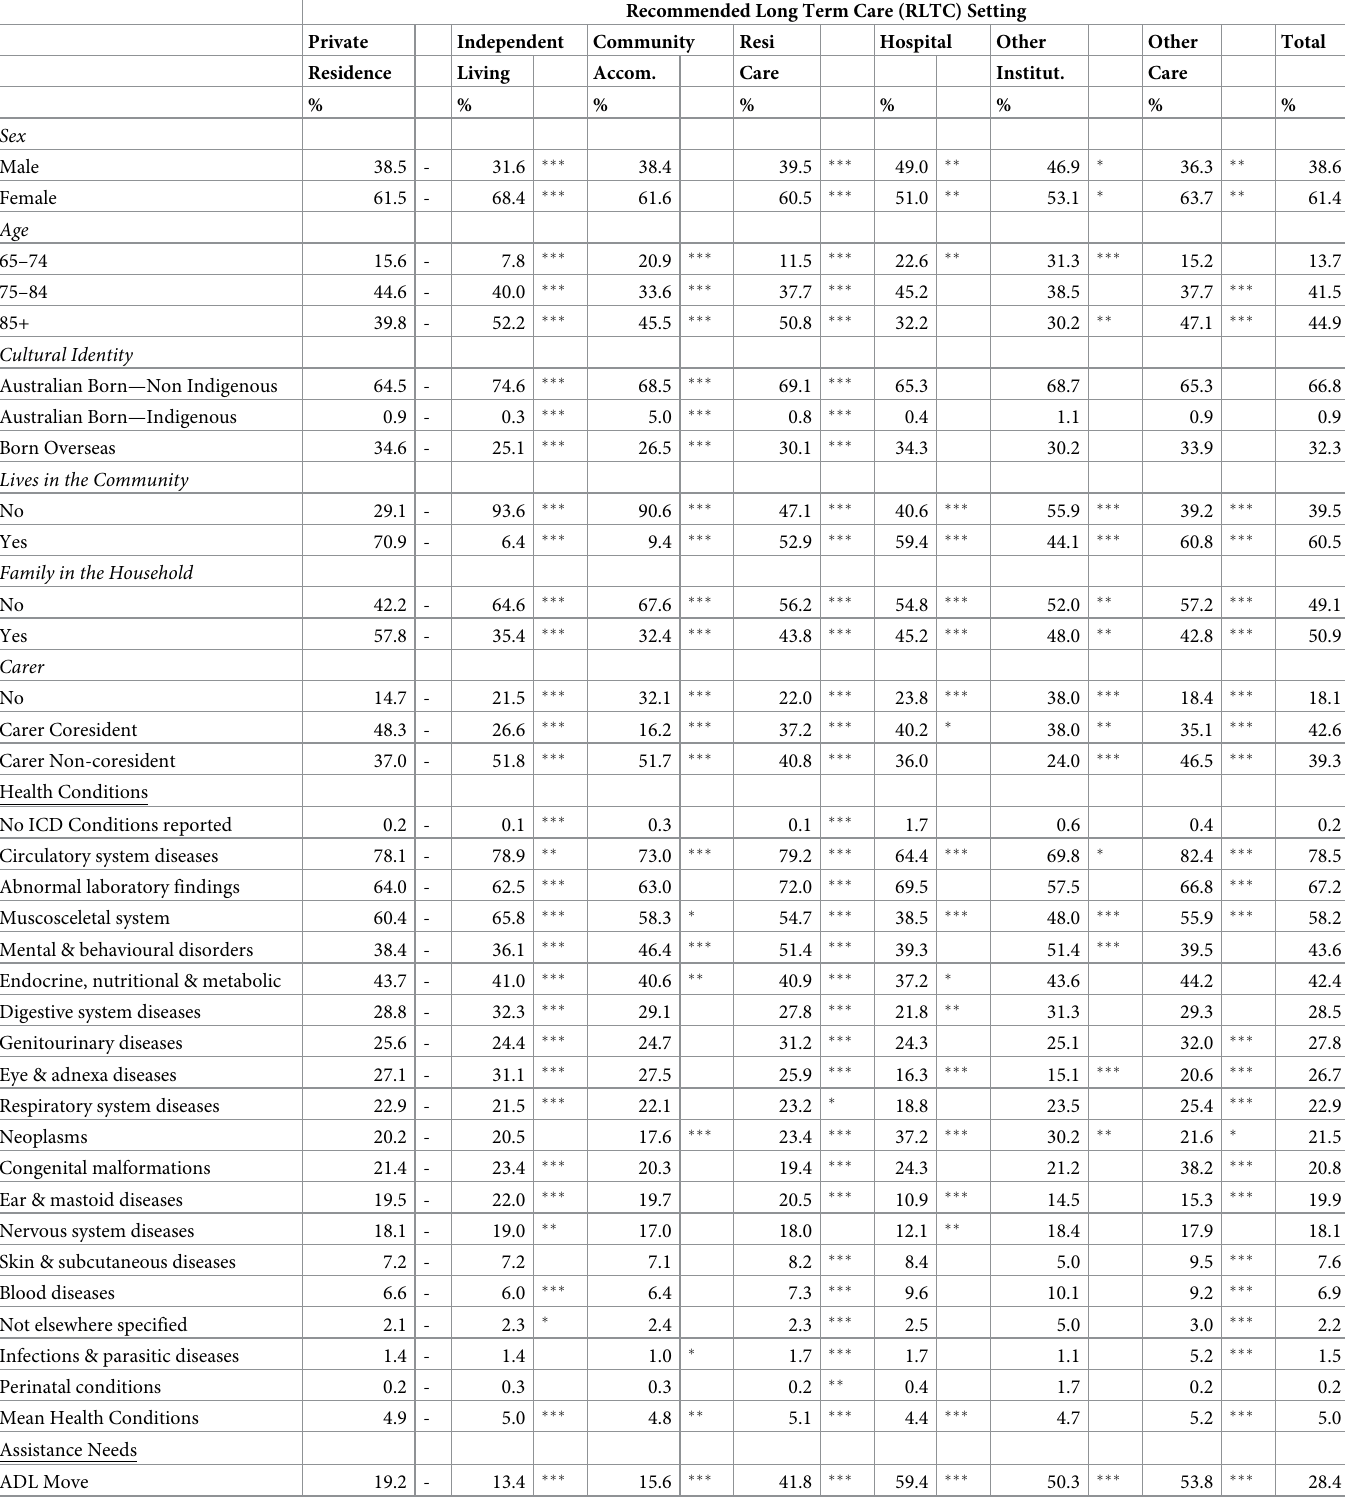
Table 4. Demographic, health and need (ADL) characteristics by recommended long term care setting (%),